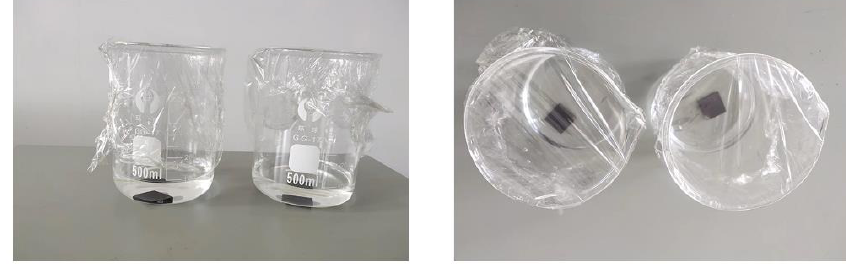
Figure 5. The immersion experiments of the samples.